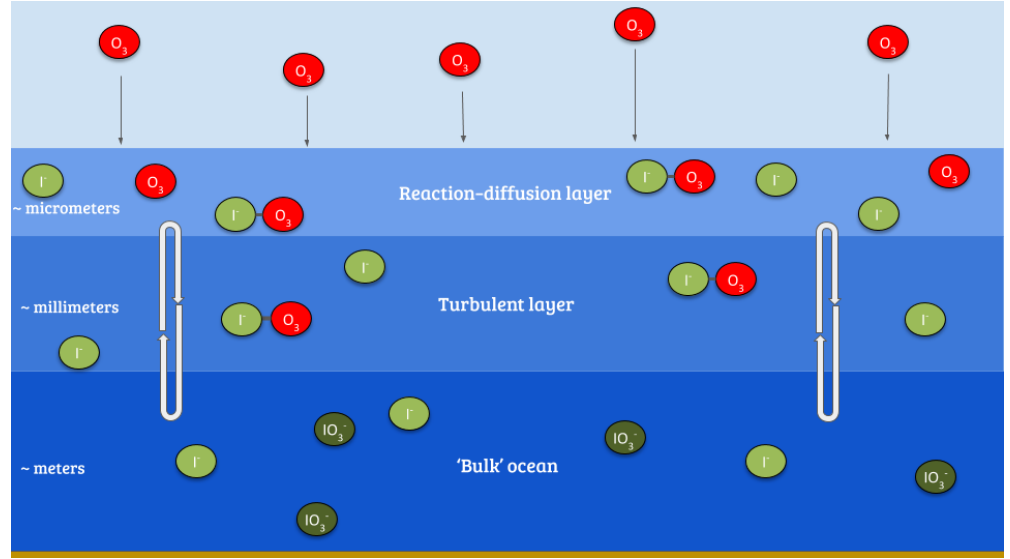
Figure 1. Illustration of the reaction of ozone with I − in the sea surface, also demonstrating a simplified version of the surface structure where the reaction